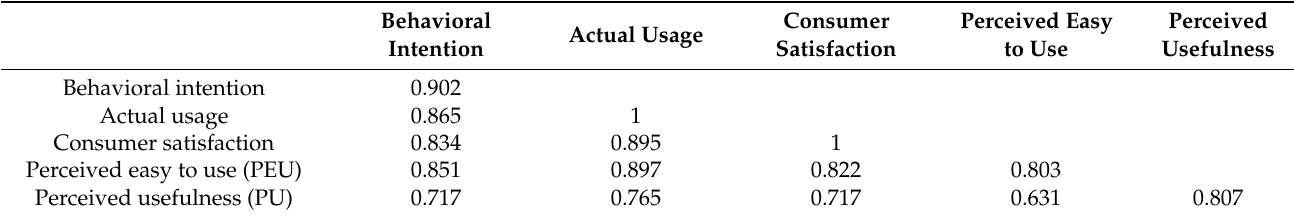
Table 4. Assessment of discriminant validity using the Fornell–Larcker criterion.